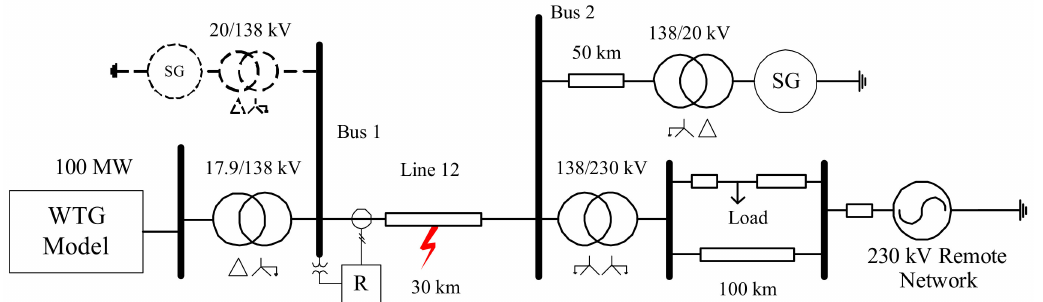
Figure 4. Single line diagram of the power system model used for testing commercial relays.